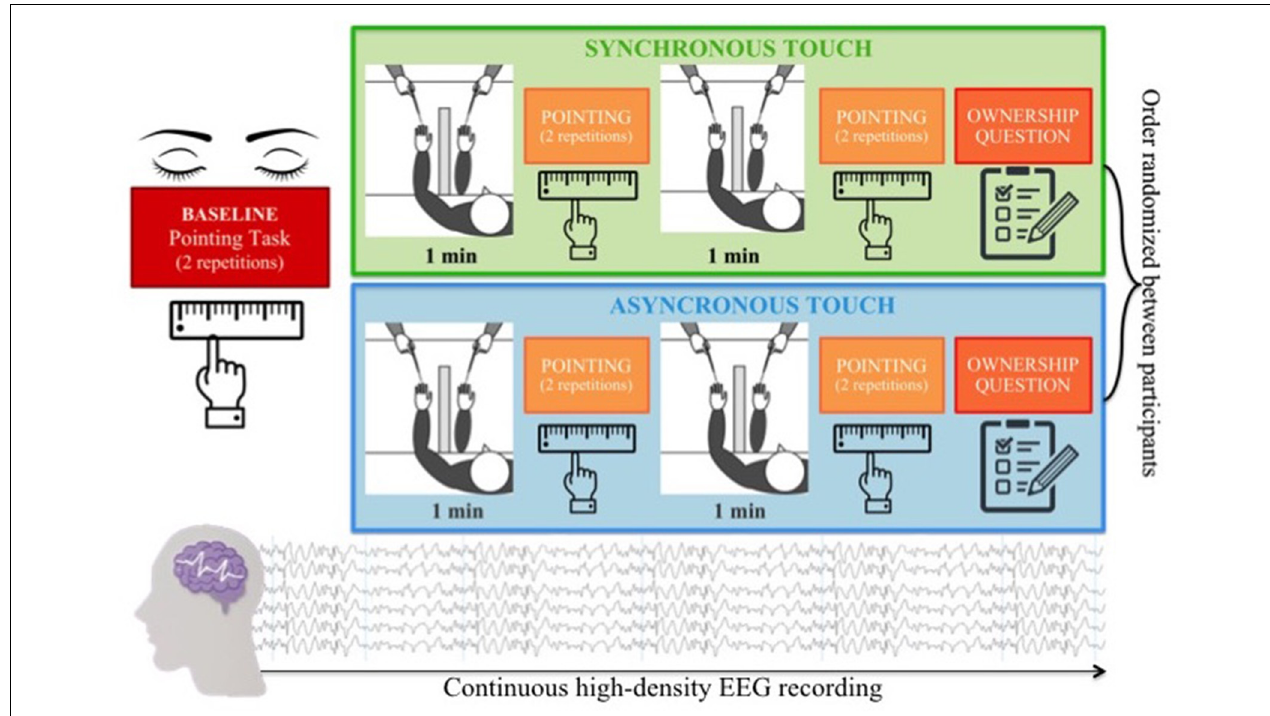
FIGURE 1 | RHI paradigm: each child was presented with two experimental blocks, varying the visual-tactile congruency (synchronous vs. asynchronous). Each block consisted of two 1-min visual-tactile stimulations immediately followed by a pointing task to measure the proprioceptive drift and a final question investigating the subjective feeling of ownership over the rubber hand. High-density EEG data were continuously recorded during the experimental session. RHI, rubber hand